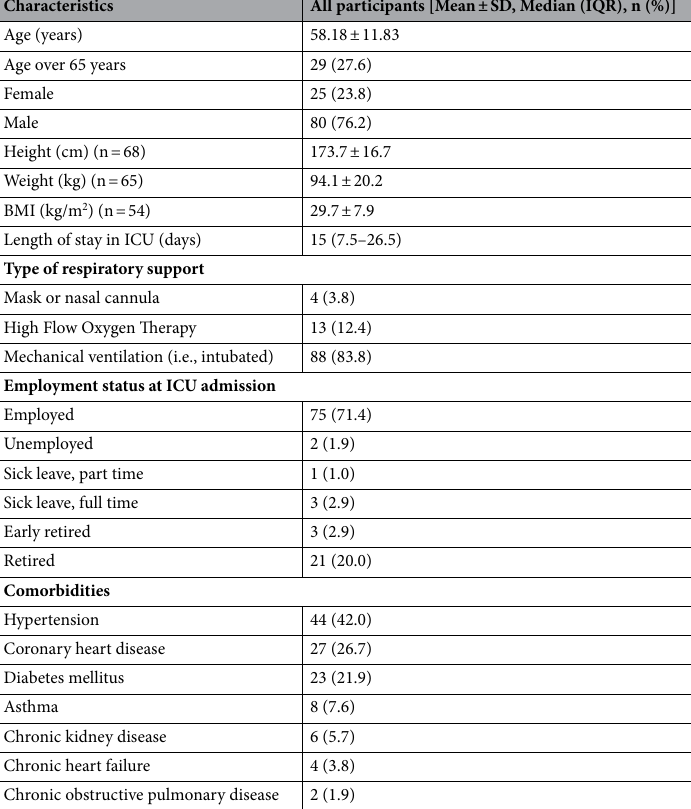
Table 1. Demographic characteristics for the 105 participants at baseline. SD standard deviation, IQR interquartile range, BMI body mass